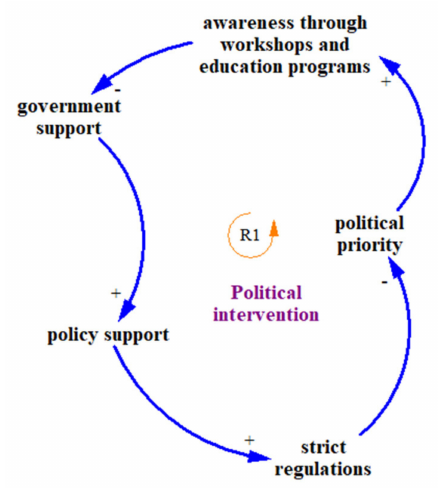
Figure 6. Reinforcing Loop